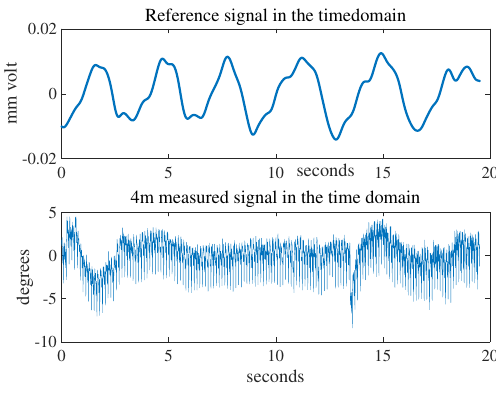
Figure 8. Receiving signals in time domain.